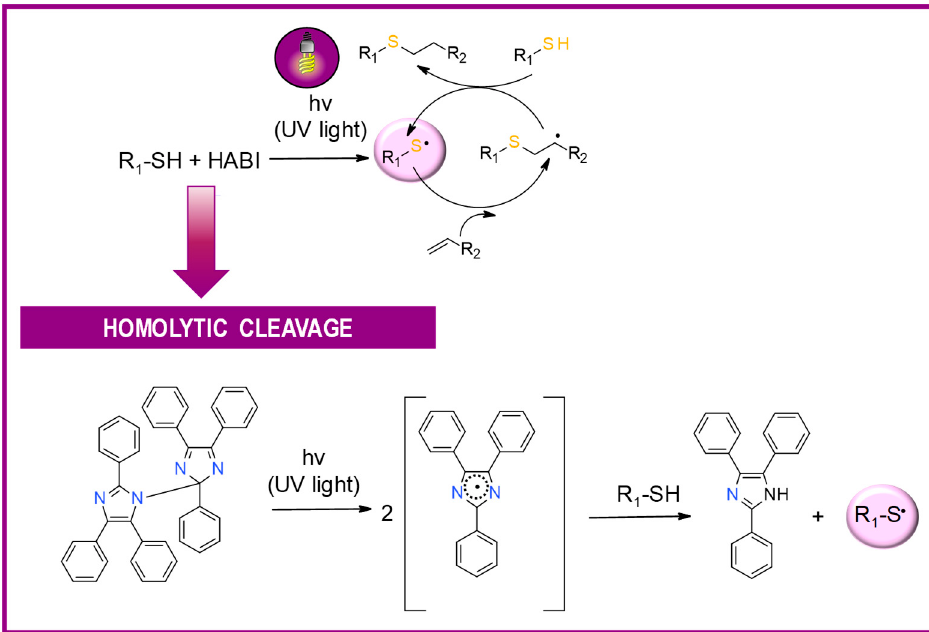
Figure 15. The radical-mediated thiol–ene polymerization mechanism.